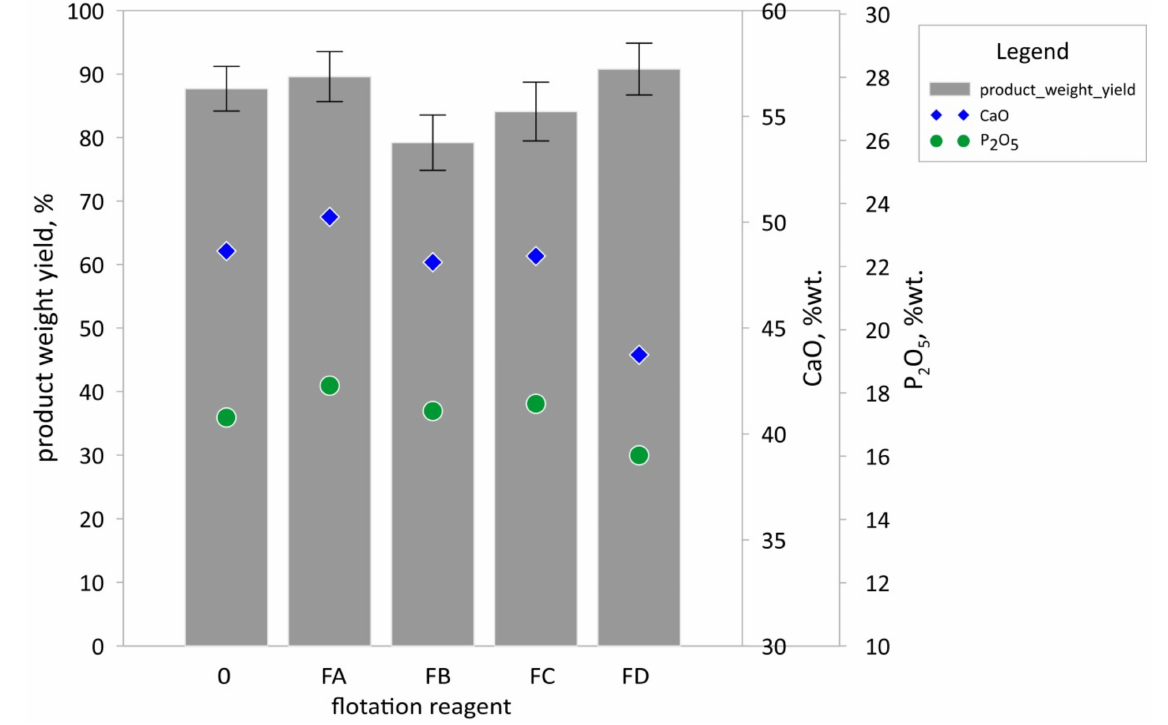
Figure 4. Flotation test results, and phosphorus and calcium contents in separated fractions. Explana- tions: 0–test without flotation reagent; flotation reagent symbols according to Table 1; bar–product weight yield mean value; whiskers–standard deviation; blue diamond–CaO content mean value; green circle–P 2 O 5 content mean value (n =